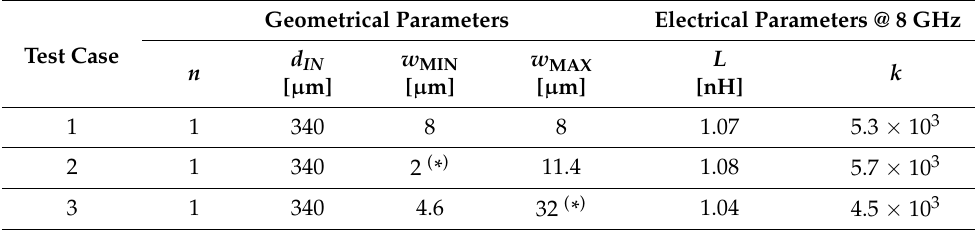
Table 3. Geometrical and electrical parameters of the three test